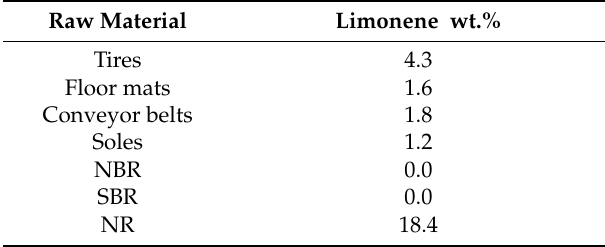
Table 4. Limonene concentration in the oil fraction (wt.%) obtained from pyrolysis of the selected raw materials. Raw